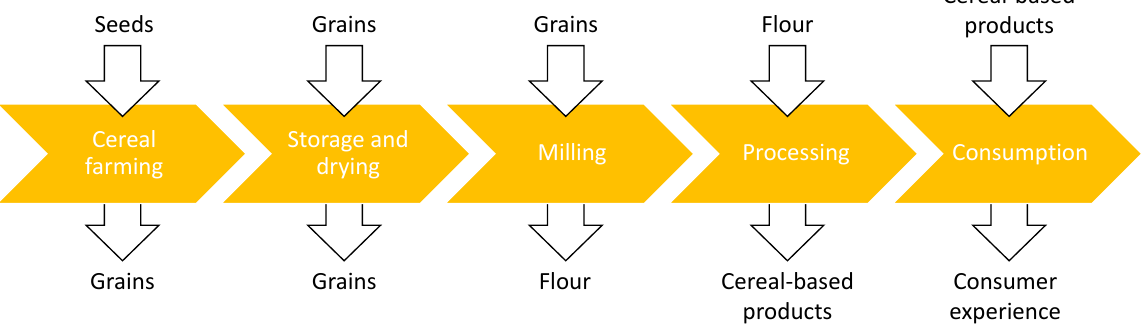
Figure 1. High-level scheme, featuring the stages of the cereal